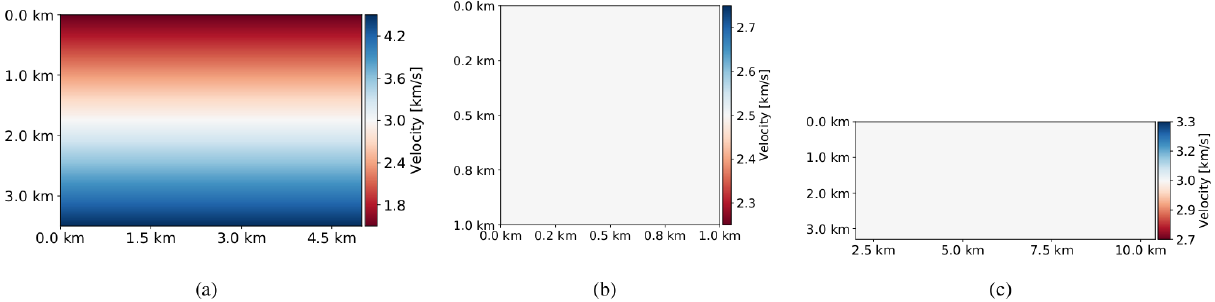
Figure 10. Initial guess of velocity model. (a) Part of the Marmousi (linear initial guess model). (b) Circle and horizontal layer velocity models (constant initial velocity of 2.5kms − 1 ). (c) 2D SEG/EAGE salt model (constant initial velocity of 3kms − 1